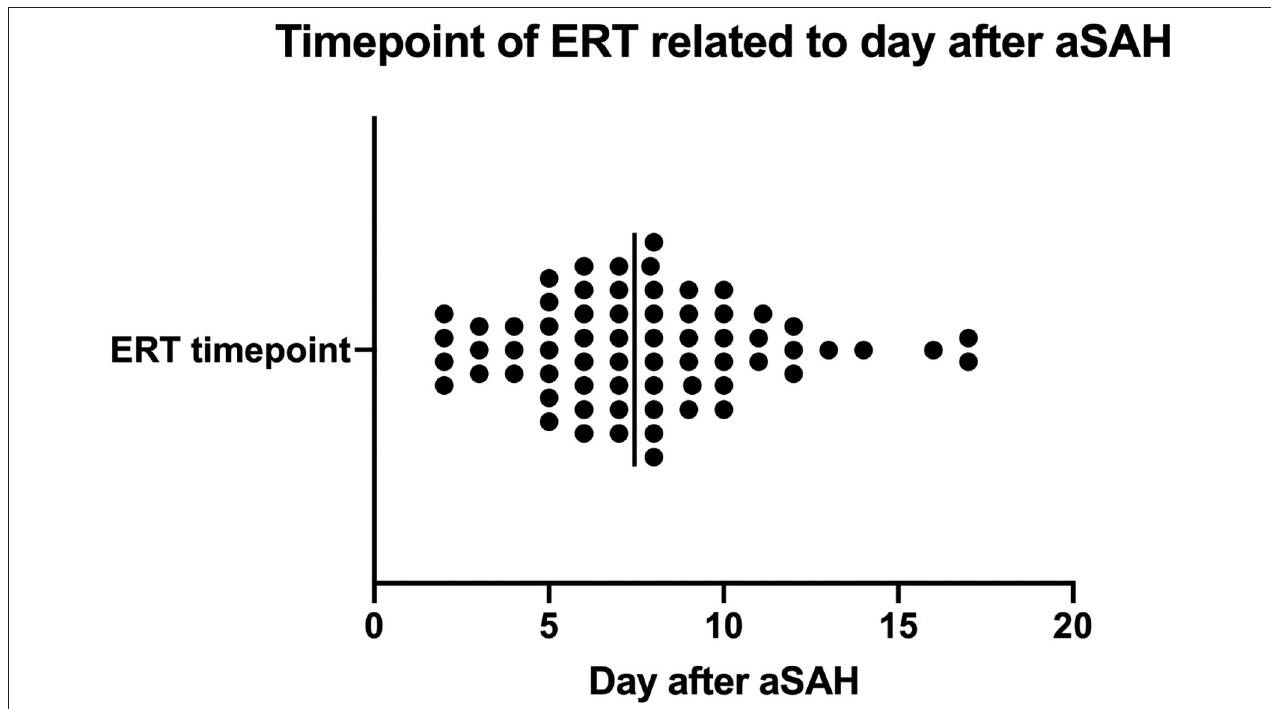
FIGURE 2 | Timepoint at which ERTs were performed in relation to the timepoint of the bleeding event (the day after aSAH diagnosis).